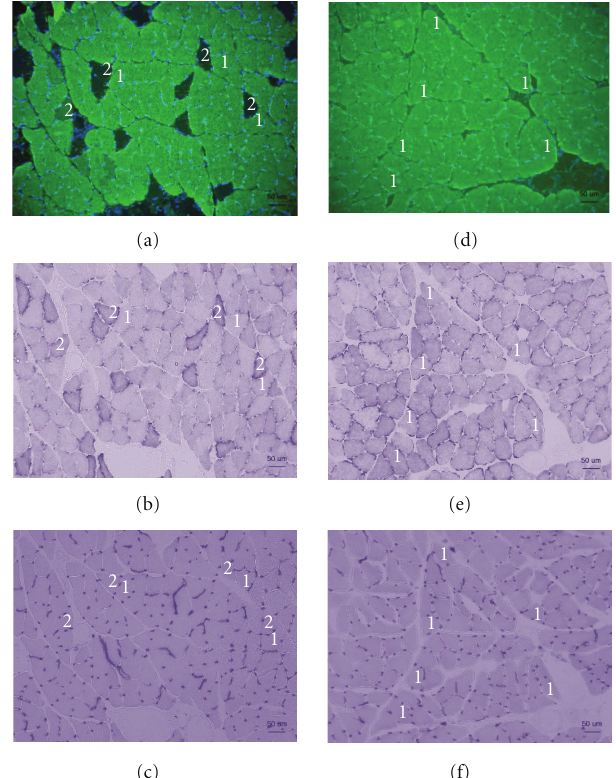
Figure 2: Serial transverse sections of the soleus muscle of the Cont (a–c) and GK (d–f) rats, stained for the myosin skeletal slow antibody (a), (d), SDH activities (b), (e), and AP activities (c), (f). 1, Type I fiber; 2, type II fiber. Scale bar: 50 μ m.